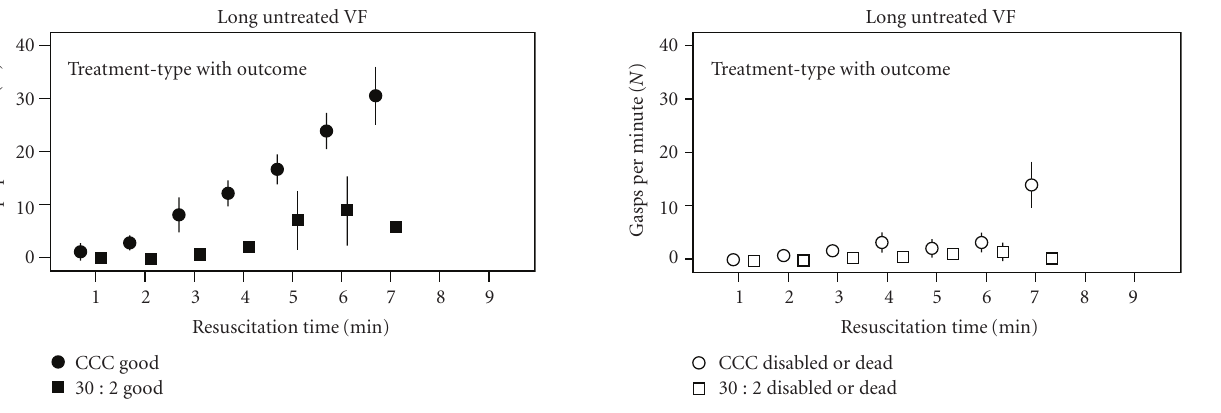
Figure 5: This figure presents the number of gasps per minute (mean ± standard error) plotted against the duration of basic resuscitation e ff orts in animals disabled or dead at 24 hours. Only those animals with 5 or 6 minutes of untreated VF (Long Untreated VF) prior to the onset of basic resuscitation are shown. Circles indicate those treated with continuous chest compression (CCC) basic resuscitation; squares indicate those treated with 30 :2 basic resuscitation prior to advanced cardiac life support. Standard error is indicated by the vertical lines. (CCC versus 30 : 2), gasping (CCC versus 30 : 2), gasping, and survival (Figure 4, Table 1). Animals receiving CCC resuscitation increased their rate of gasping faster, achiev- ing a higher frequency per minute compared with those receiving the 30 : 2 compressions to ventilations (Figure